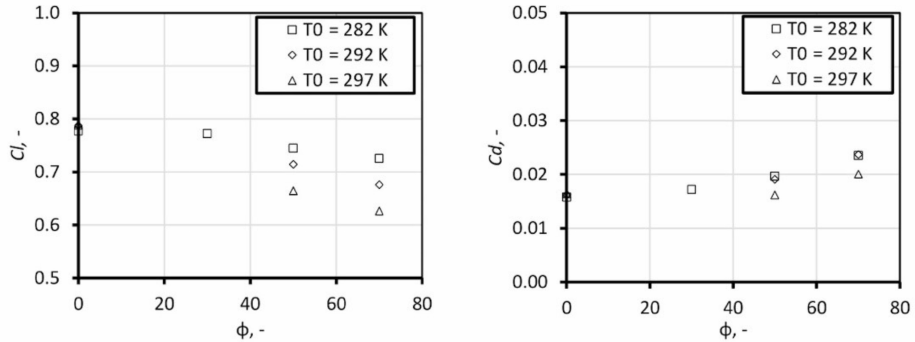
Figure 14. Lift coe ffi cient (left) and drag coe ffi cient (right) change with the increase of relative humidity and total